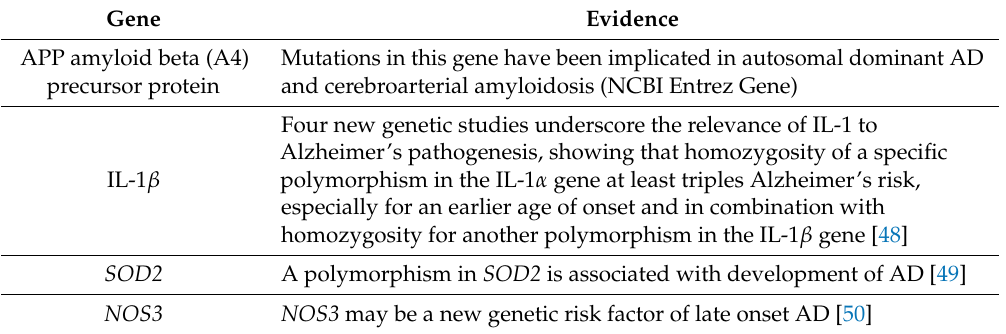
Table 1. Some of the genes associated with Alzheimer’s disease (AD) that were used in this study. Gene Evidence APP amyloid beta (A4) Mutations in this gene have been implicated in autosomal dominant AD precursor protein and cerebroarterial amyloidosis (NCBI Entrez Gene) Four new genetic studies underscore the relevance of IL-1 to Alzheimer’s pathogenesis, showing that homozygosity of a specific IL-1 β polymorphism in the IL-1 α gene at least triples Alzheimer’s risk, especially for an earlier age of onset and in combination with homozygosity for another polymorphism in the IL-1 β gene [48] SOD2 A polymorphism in SOD2 is associated with development of AD [49] NOS3 NOS3 may be a new genetic risk factor of late onset AD